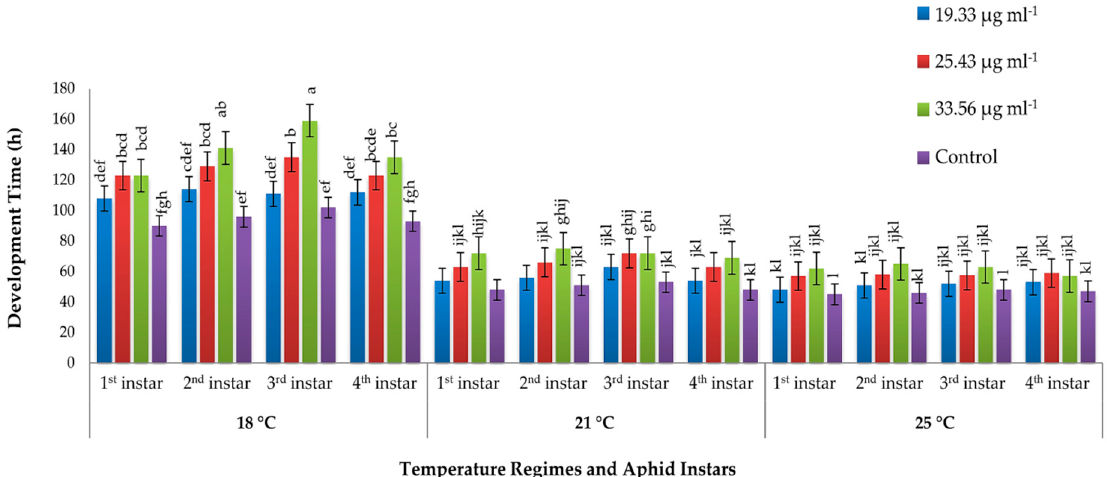
Figure 1. Mean nymphal development time ( ± SE) of green peach aphid ( Myzus persicae ) in response to the application of elicitor PeBC1 at different temperature regimes ( n = 10). Different letters indicate significant differences among treatments (one-way factorial ANOVA; LSD at α = 0.05).